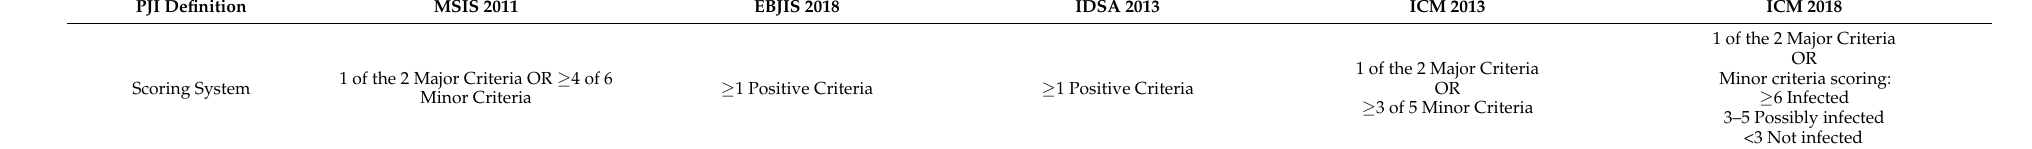
Table A1. Diagnostic criteria for periprosthetic joint